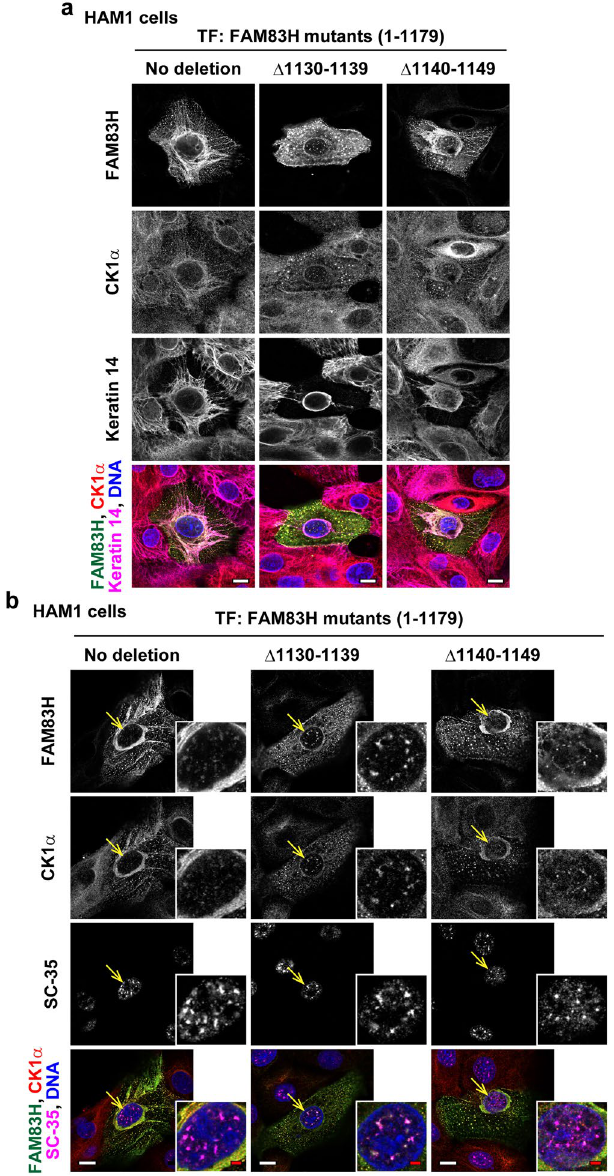
Figure 6. Immunofluorescence of human ameloblastoma HAM1 cells. HAM1 cells were transfected with the plasmids encoding the indicated FAM83H mutants and were analyzed via immunofluorescence using antibodies for ( a ) FAM83H (green), CK1α (red), and keratin 14 (magenta) or ( b ) FAM83H (green), CK1α (red), and SC-35 (magenta). Nuclei were visualized by DAPI (blue). ( b ) Magnified images of the nuclei pointed by yellow arrows are shown. White and red bars indicate 10 and 2 μm,